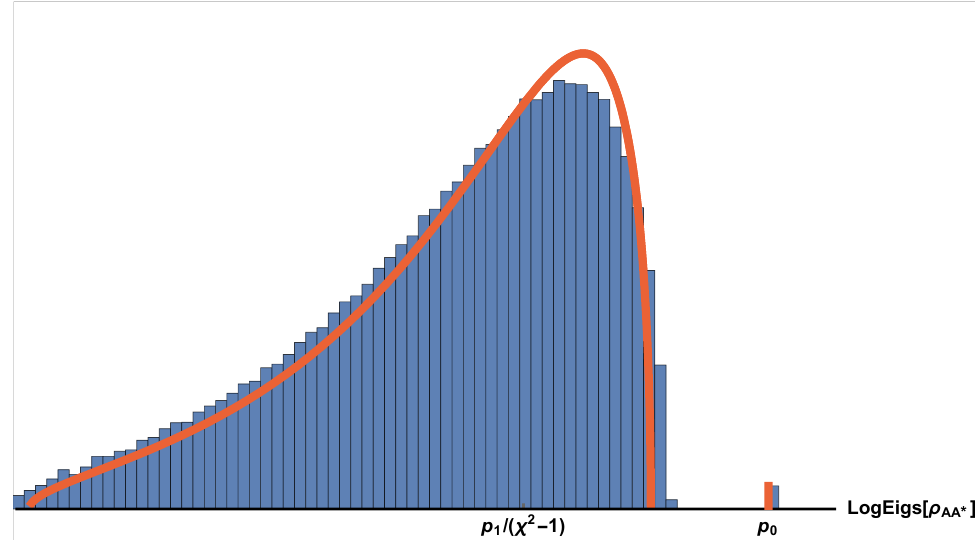
Figure 16 . The blue histogram is a numerical plot of the spectrum of ρ AA ? for a tripartite tensor. The orange curve is our analytic prediction for the spectrum eq. (3.90). Note that the tick values on the x-axis are not exactly p from eq. (1.6), but instead include a small correction, replacing p 0 with its shifted version eq. (C.39), differing only at O (log( χ ) /χ 2 ) . This gives the value in the plot of p = 0 . 226 0